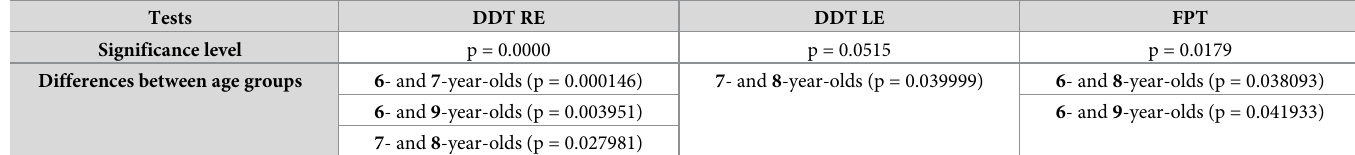
Table 10. Post hoc analysis of differences among age groups, in the percentage of the standard, for each age group, in group”S”.